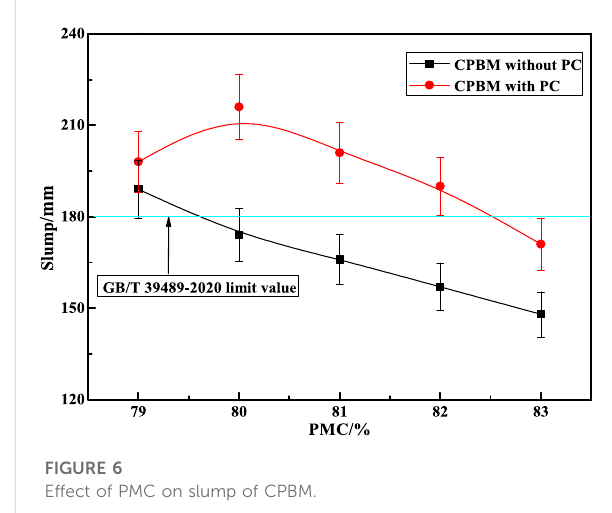
FIGURE 4 Effect of SS content on compressive strength of CPBM.